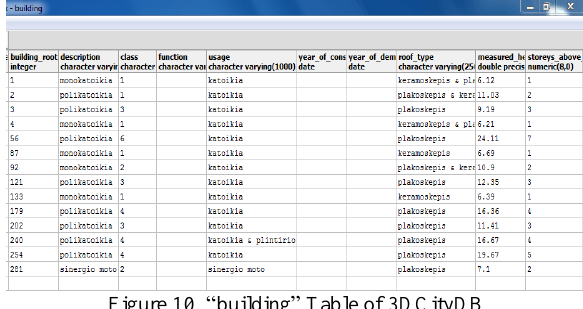
Figure 11. Example #1 of Spatial Query on